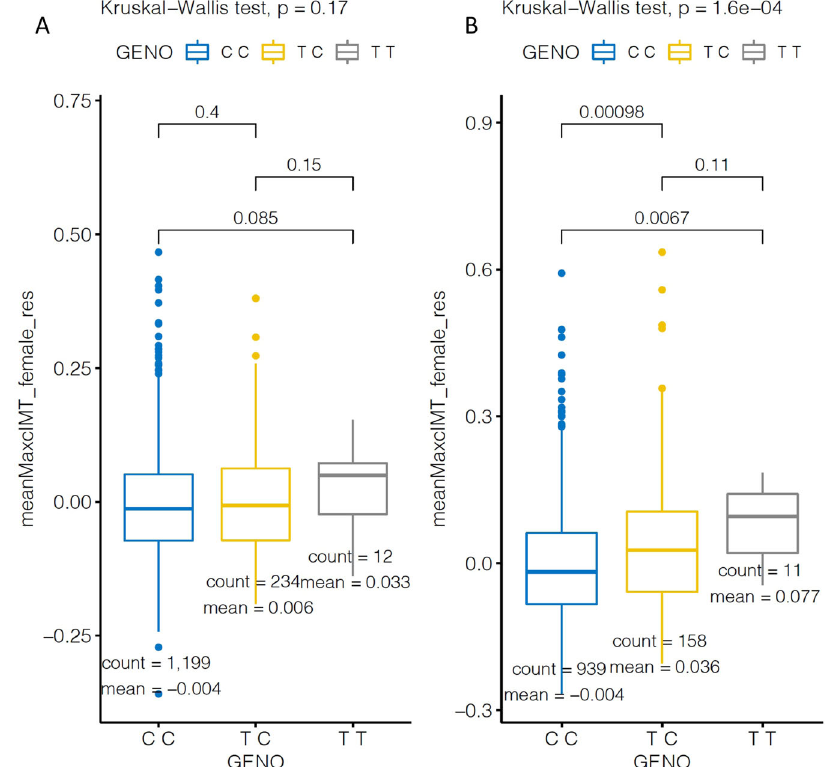
Fig. 4 Genotype plots for genetic associations of rs115473055 strati fi ed by menopausal status. A Pre-menopausal women ( n = 1245), B Post- menopausal women ( n = 1108) with cIMT. Bounds of boxes represent 1st and 3rd quintiles, bars represent 95th percentiles,